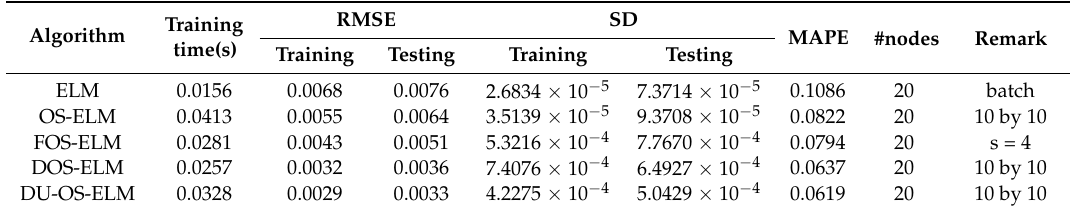
Table 5. Comparison results of different